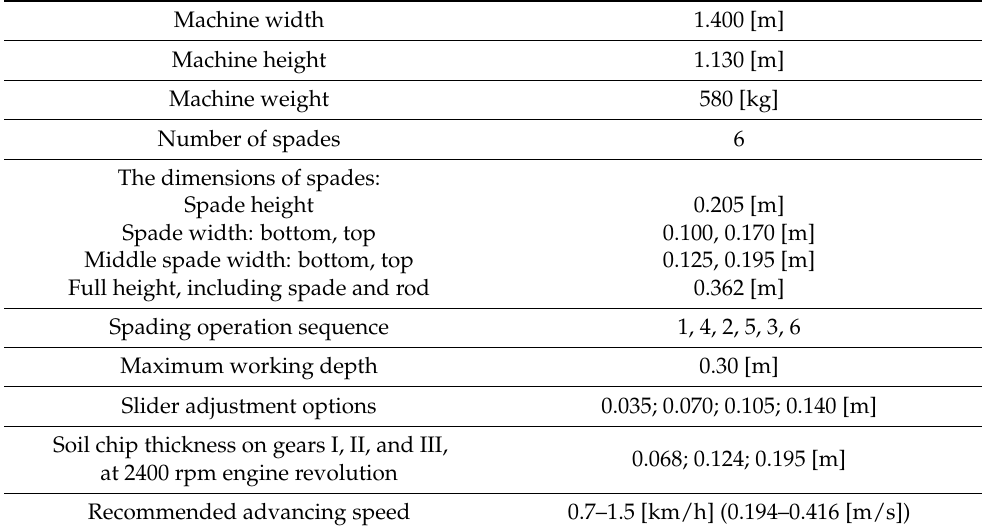
Table 1. Technical data of the MS-140-type spading